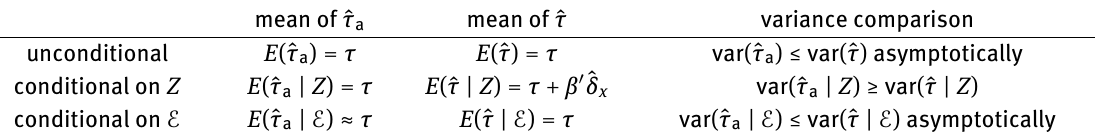
Table 1: Comparison under the data generating process in (a)–(e) mean of ^ τ a mean of ^ τ variance comparison unconditional E (^ τ a ) = τ E (^ τ ) = τ var (^ τ a ) ≤ var (^ τ ) asymptotically ^ conditional on Z E (^ τ a | Z ) = τ E (^ τ | Z ) = τ + β ′ δ x var (^ τ a | Z ) ≥ var (^ τ | Z ) conditional on E E (^ τ a | E ) ≈ τ E (^ τ | E ) = τ var (^ τ a | E ) ≤ var (^ τ | E )